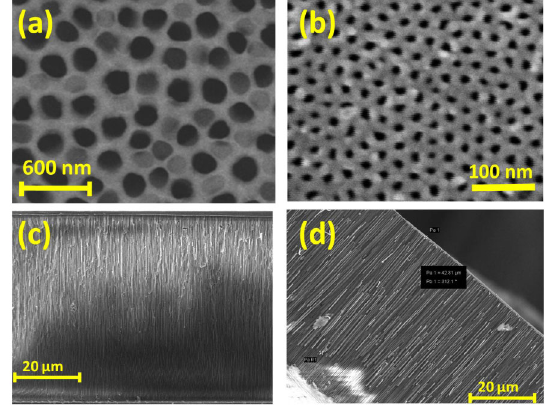
respectively.FIG. 3. SEM images of surface of hollow PAA templates of diameter (a) 200 nm and (b) 20 nm, respectively. Cross section SEM image of hollow PAA (c) and metal-filled PAA (d)